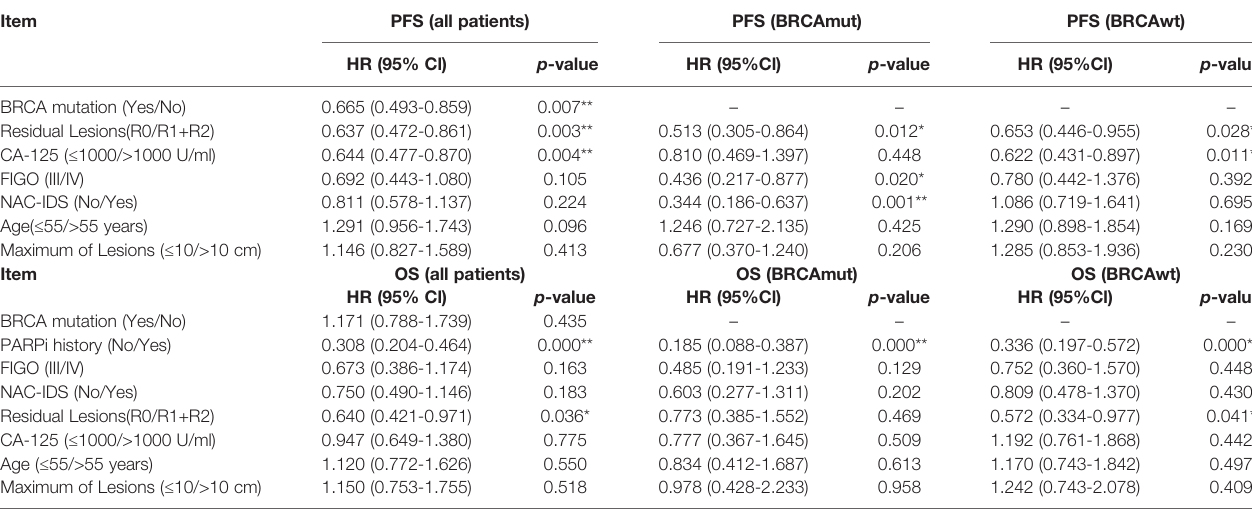
TABLE 5 | Multivariate analysis of prognostic markers related to prognoses. Item PFS (all patients)